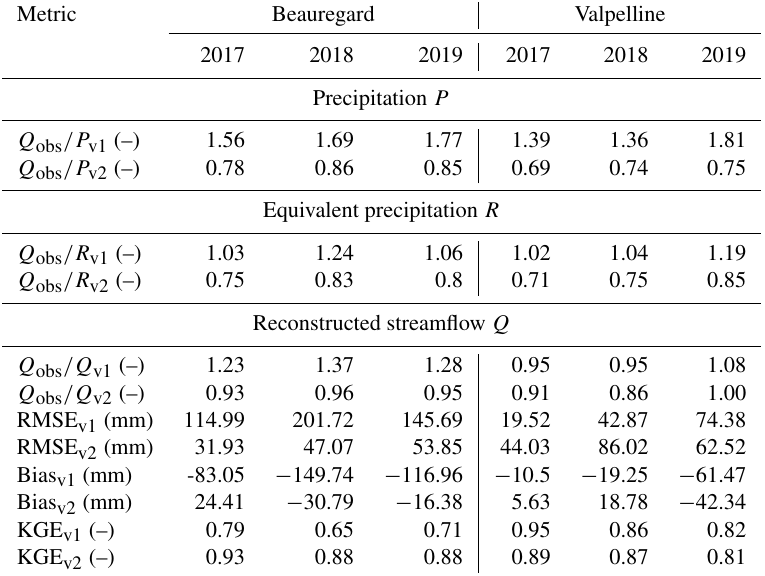
Table 2. Evaluation metrics of Flood-PROOFS simulations driven by GRISO1 vs. those driven by GRISO2. The first distributed precipitation used only precipitation gauges, whereas the second included an orographic correction developed in the present study based on snow courses. Q , P , and R are annual streamflow, precipitation, and equivalent precipitation, respectively (with equivalent precipitation being the sum of rainfall, snowpack runoff, and glacier runoff). The terms obs, v1, and v2 refer to observed data and simulated data, according to GRISO1 and GRISO2, respectively. RMSE is the root mean square error, bias is simulated minus observed, and KGE is the Kling–Gupta efficiency, according to Kling et al.